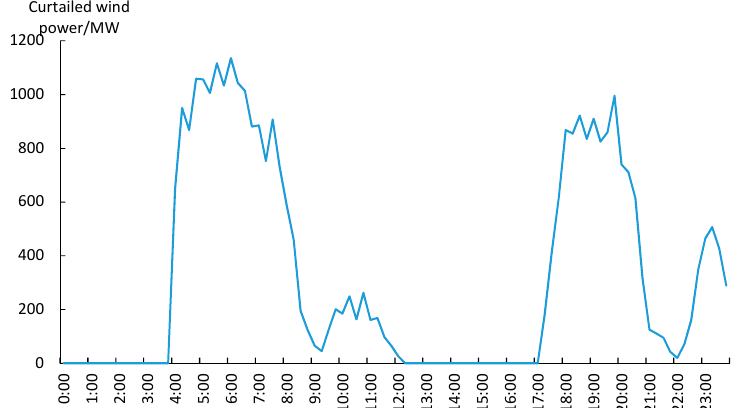
Figure 7. Curtailed wind power in the conventional dispatching mode.